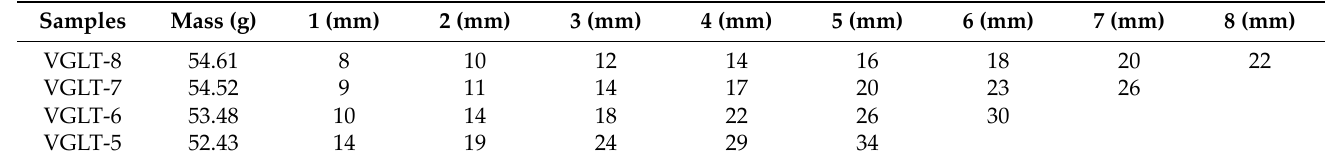
Table 7. Detailed data on the height of each floor of the VGLT hybrid